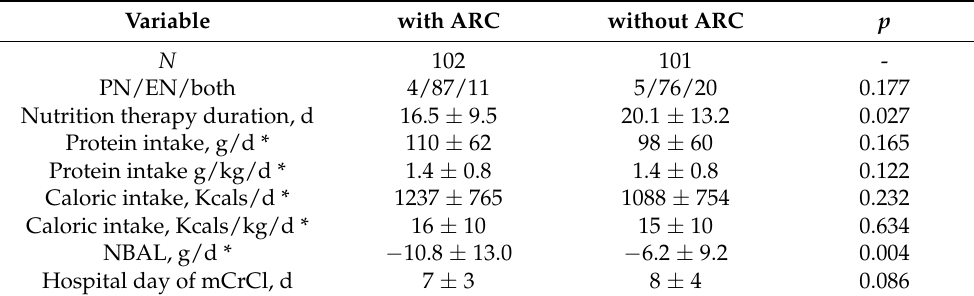
Table 2. Nutrition therapy.